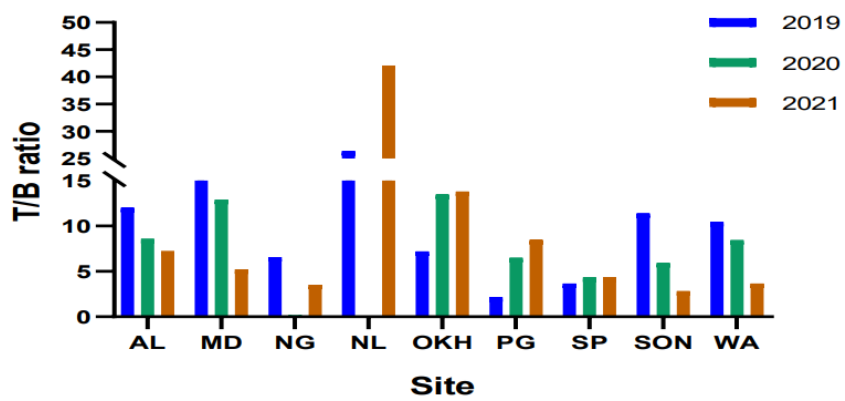
Figure 4. T/B ratio at all industrial monitoring stations for years 2019, 2020, and 2021. Correlations among VOC levels can help one to understand the source of origin of the different constituents. If the correlation between different pollutants is similar, it de- picts that their source of origin might be the same. The correlation value was found by using the Pearson correlation coefficient for the mean VOC levels on a daily basis. These correlation data were classified into various categories depending on the coefficient value (from − 1 to 1). A coefficient value from 0.8 to 1.0 indicated a very strong correlation, a coefficient value from 0.6 to 0.8 indicated a strong correlation, a coefficient value from 0.4 to 0.6 indicated a moderate correlation, a coefficient value from 0.2 to 0.4 indicated a weak correlation, and a coefficient value from 0 to 0.2 indicated irrelevant data. [50]. In the pre- sent study, a very strong positive correlation was observed between the NG and MD mon- itoring stations (0.734) during the pre-pandemic period, whereas other monitoring sta- tions reported moderate to low correlations. In a similar study in Maharashtra, the authors reported a significantly strong correlation between the Thane and Bandra monitoring sta- tions (0.73) in the pre-lockdown period [19]. The correlations among the different moni- toring stations are presented in Tables 2 – 4. Table 3. Correlation between the different monitoring stations during the pandemic period. AL